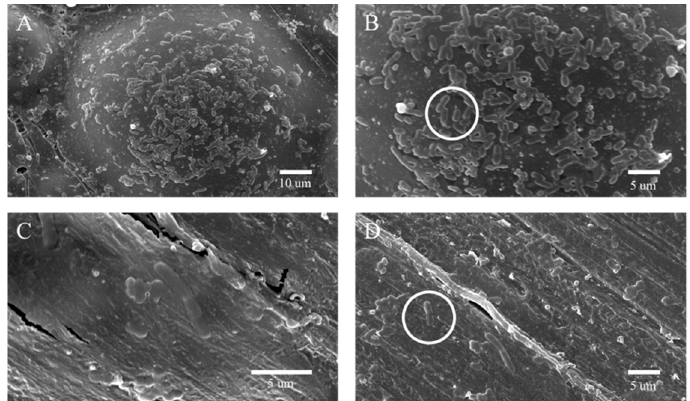
Figure 8. SEM morphologies of S. mutans on the samples after being cultured for 12 h. ( A , B ) The co ‐ culture surface of hAP (0 wt%) and bacterial solution. Circle notes in the ( B ) indicate the typical morphology of bacteria before antibacterial test. ( C , D ) The co ‐ culture surface of hAP (1.4 wt%) and bacterial solution. Circle notes indicate the change of bacterial morphology after antibacterial test in ( D ).